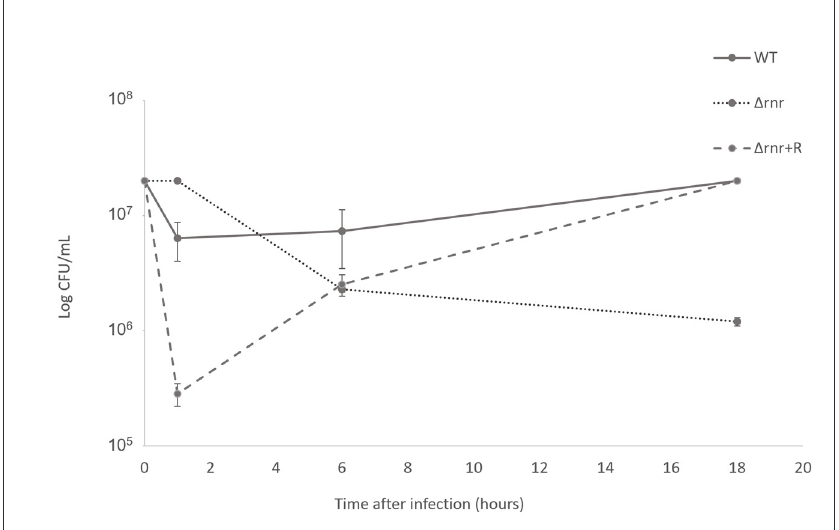
Figure 3. Hemolymph bacterial load in the course of S. pneumoniae infection. The viable bacterial load was determined in the hemolymph extracted from larvae infected with 5 × 10 6 bacteria/larvae of the S. pneumoniae wild type (wt), RNase R mutant ( ∆ rnr ), and complemented ( ∆ rnr +R) strains during a period within the time course of infection. Results (number of colony forming units (CFU) per mL of hemolymph obtained at 1, 6, and 18 h postinfection) represent means of at least three independent experiments.